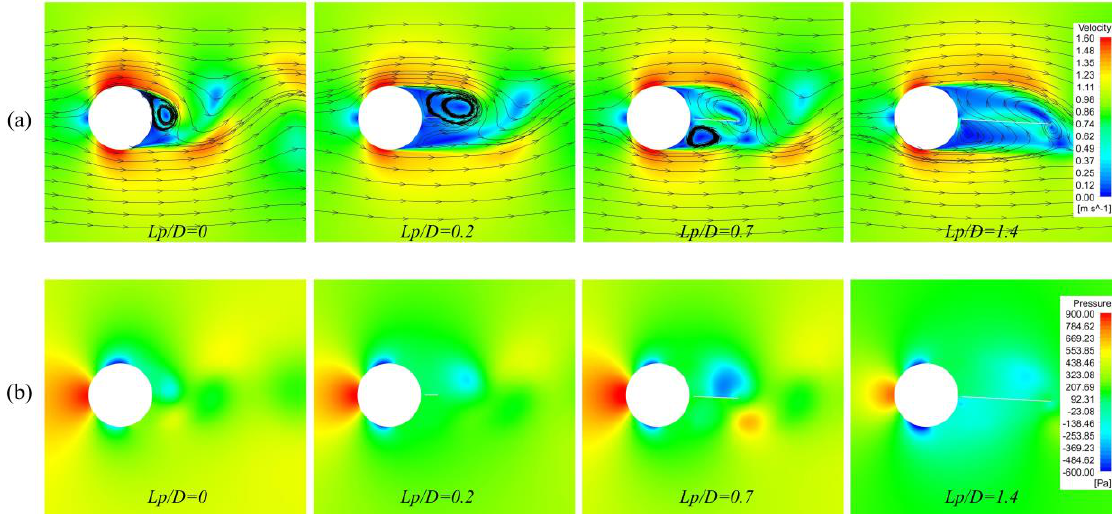
Figure 17. Velocity contours with streamlines ( a ) and pressure contours ( b ) for different plate lengths.